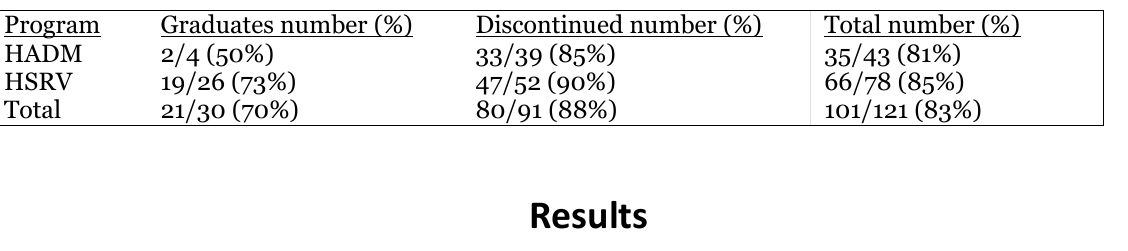
HADM and HSRV Participants Reached From 2010 Pilot